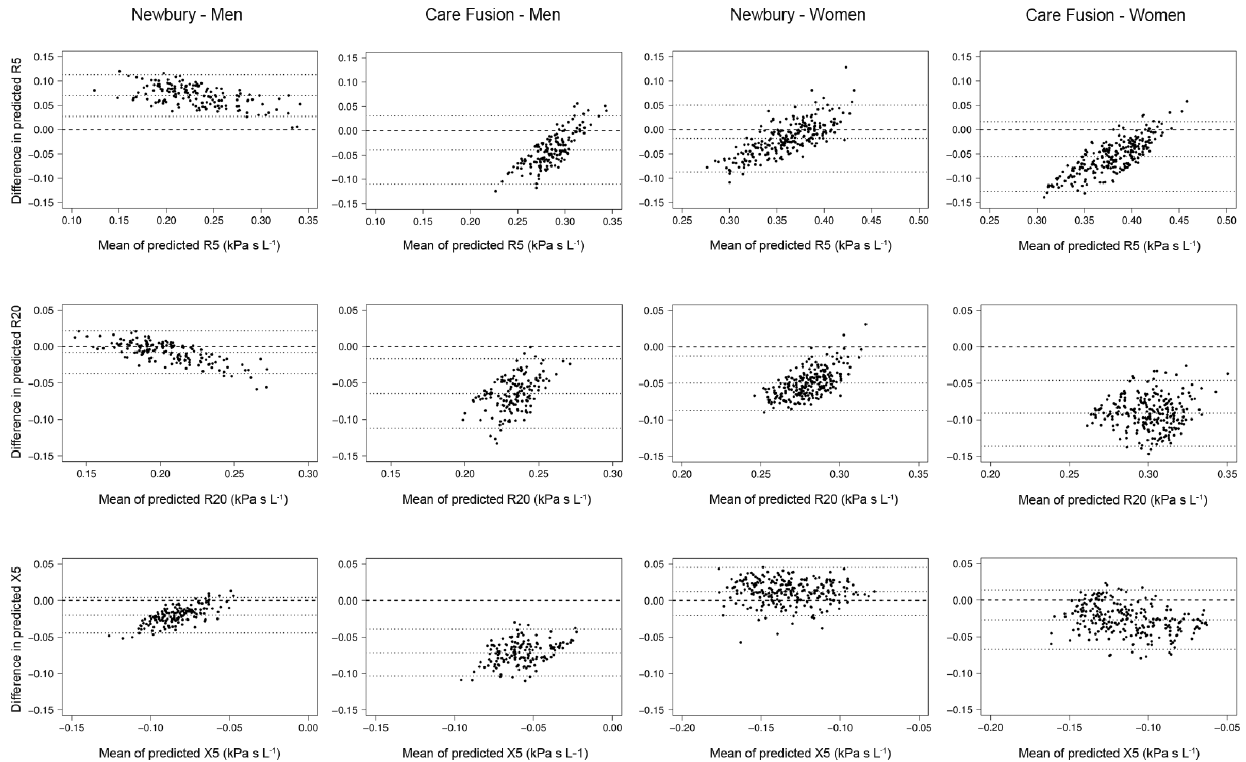
Figure 1. Bland-Altman plots for R5, R20, and X5. Vogel & Smidt 1994 (Care Fusion) [2], Newbury et al. 2008 [15].